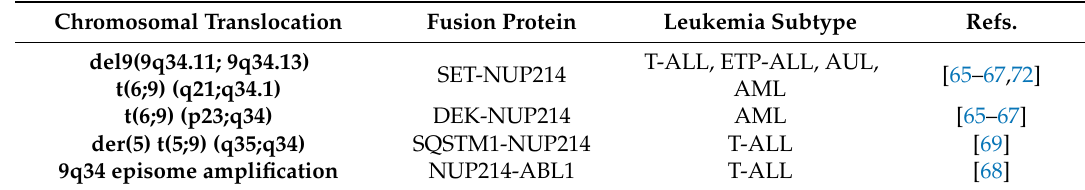
Table 1. Chromosomal translocations involving the NUP214 gene and resulting fusion proteins reported in the